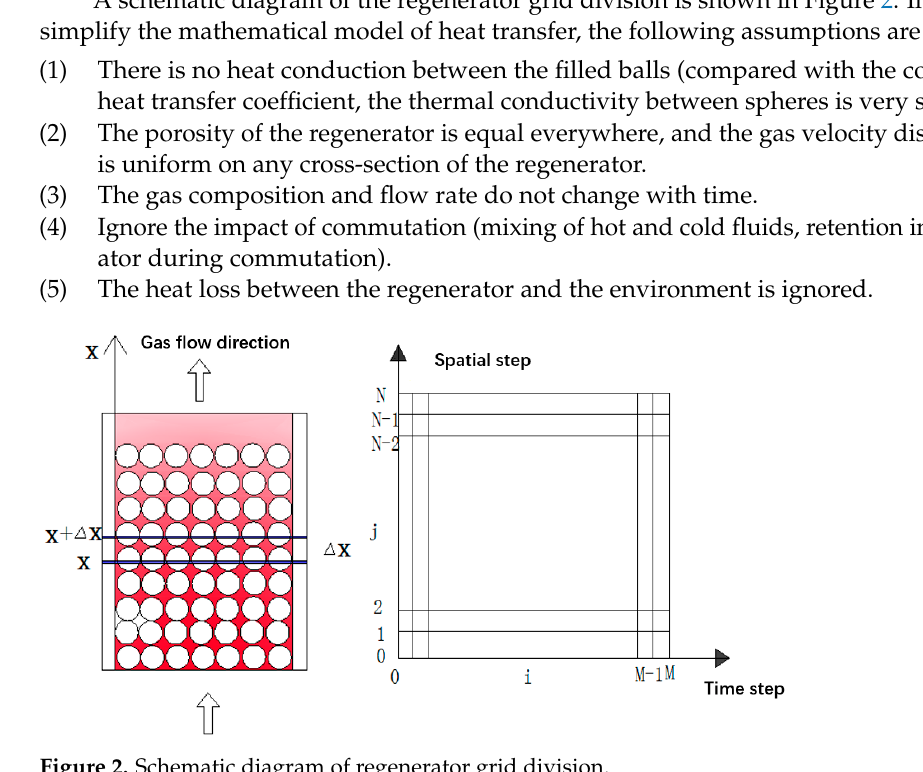
Figure 2. Schematic diagram of regenerator grid division.